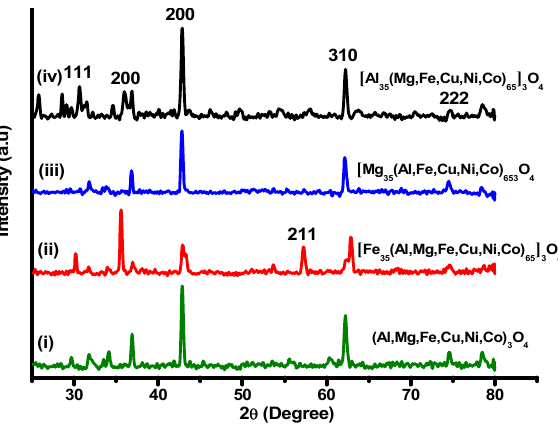
Figure 1. XRD patterns for equiatomic HEOs (i) and non-equiatomic HEOs (ii–iv). Table 1. Calculated average crystallite sizes of HEOs using Debye–Scherer equation. Serial No.